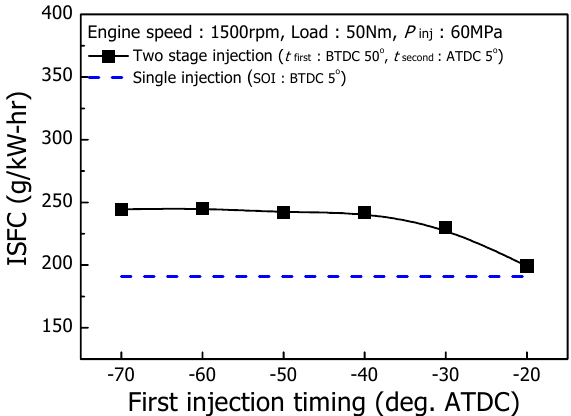
Figure 4. Indicated specific fuel consumption according to first injection timing of two stage